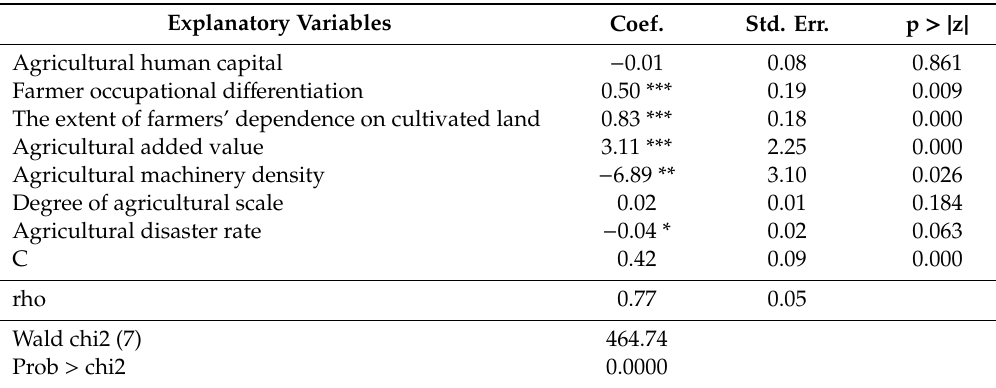
Table 3. Tobit regression results of the GUECL influencing